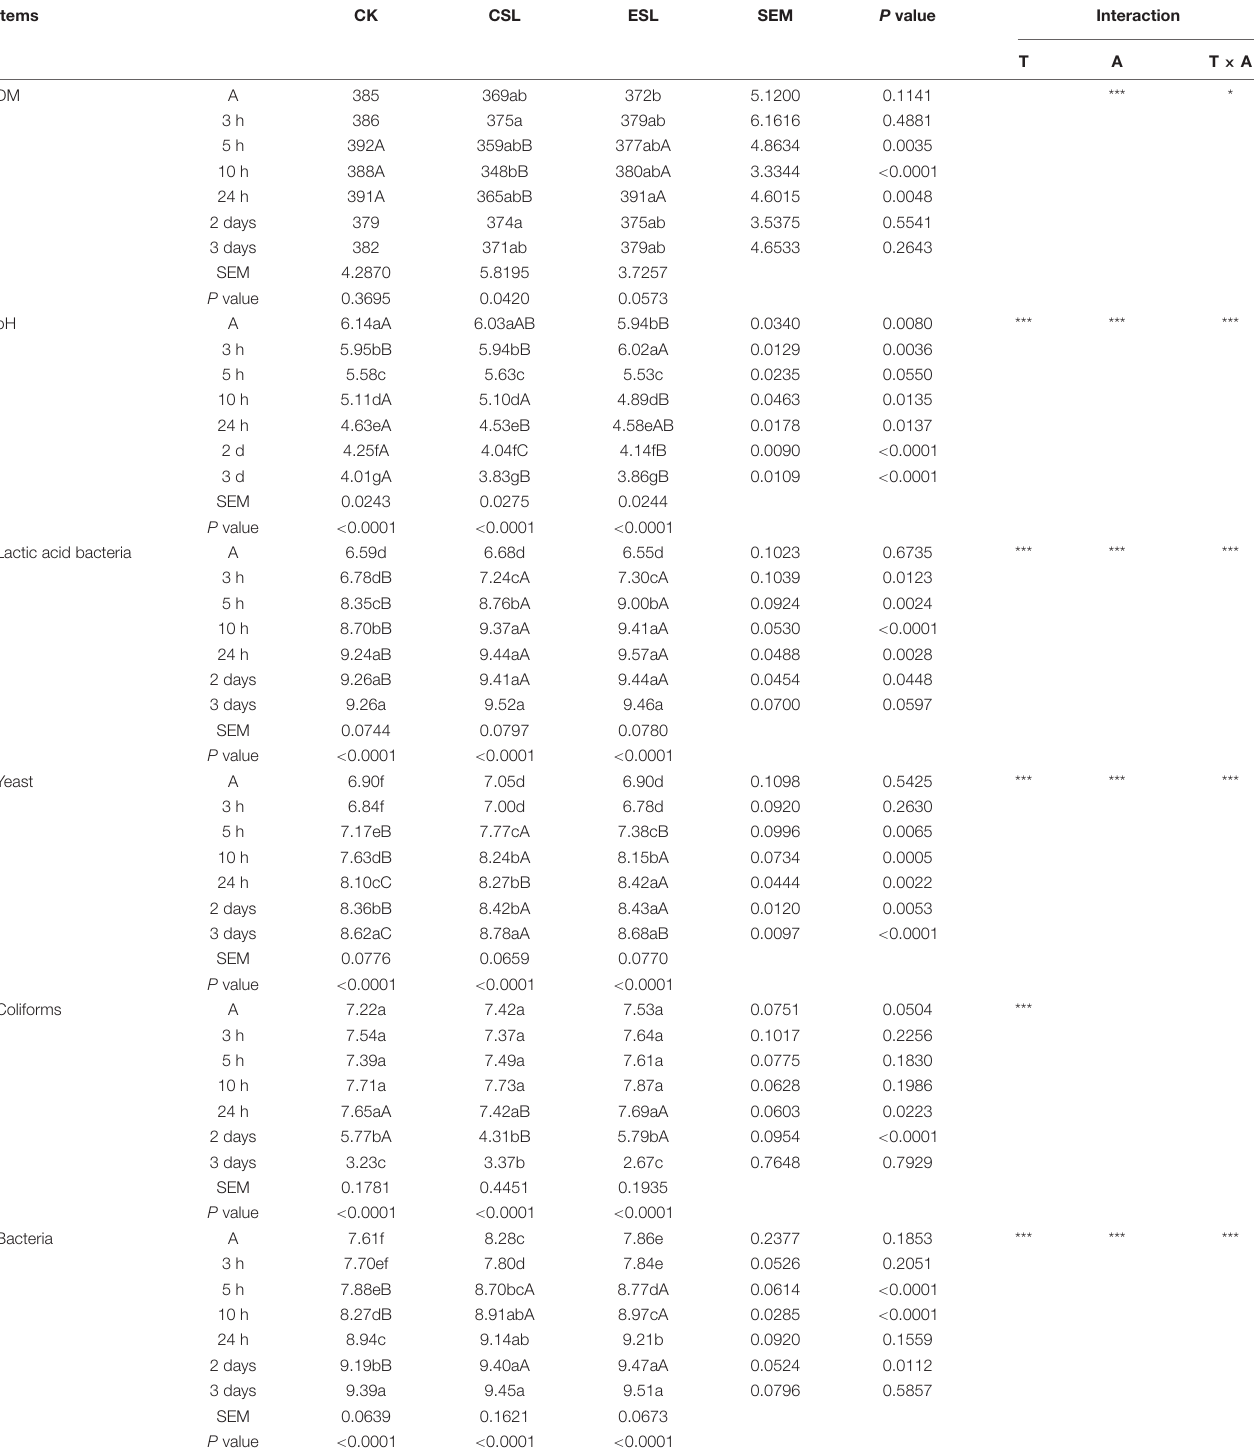
TABLE 3 | Dry matter (DM, g/kg) and microbial counts (log 10 colony-forming units/g fresh weight) of whole-plant corn silage during the intense fermentation phase.